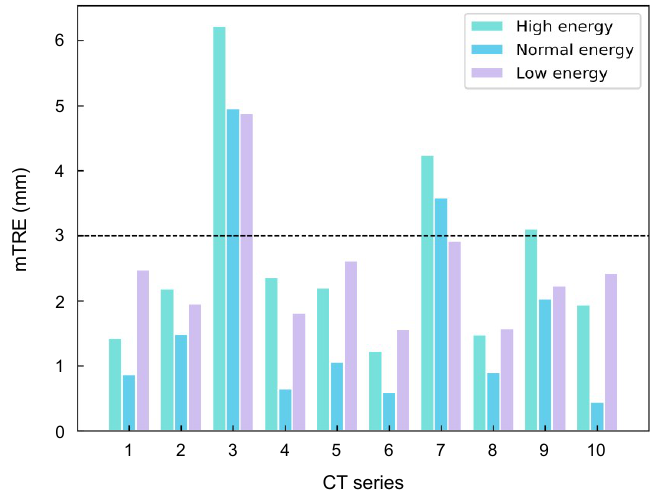
Figure 12. The mTRE of different energies.